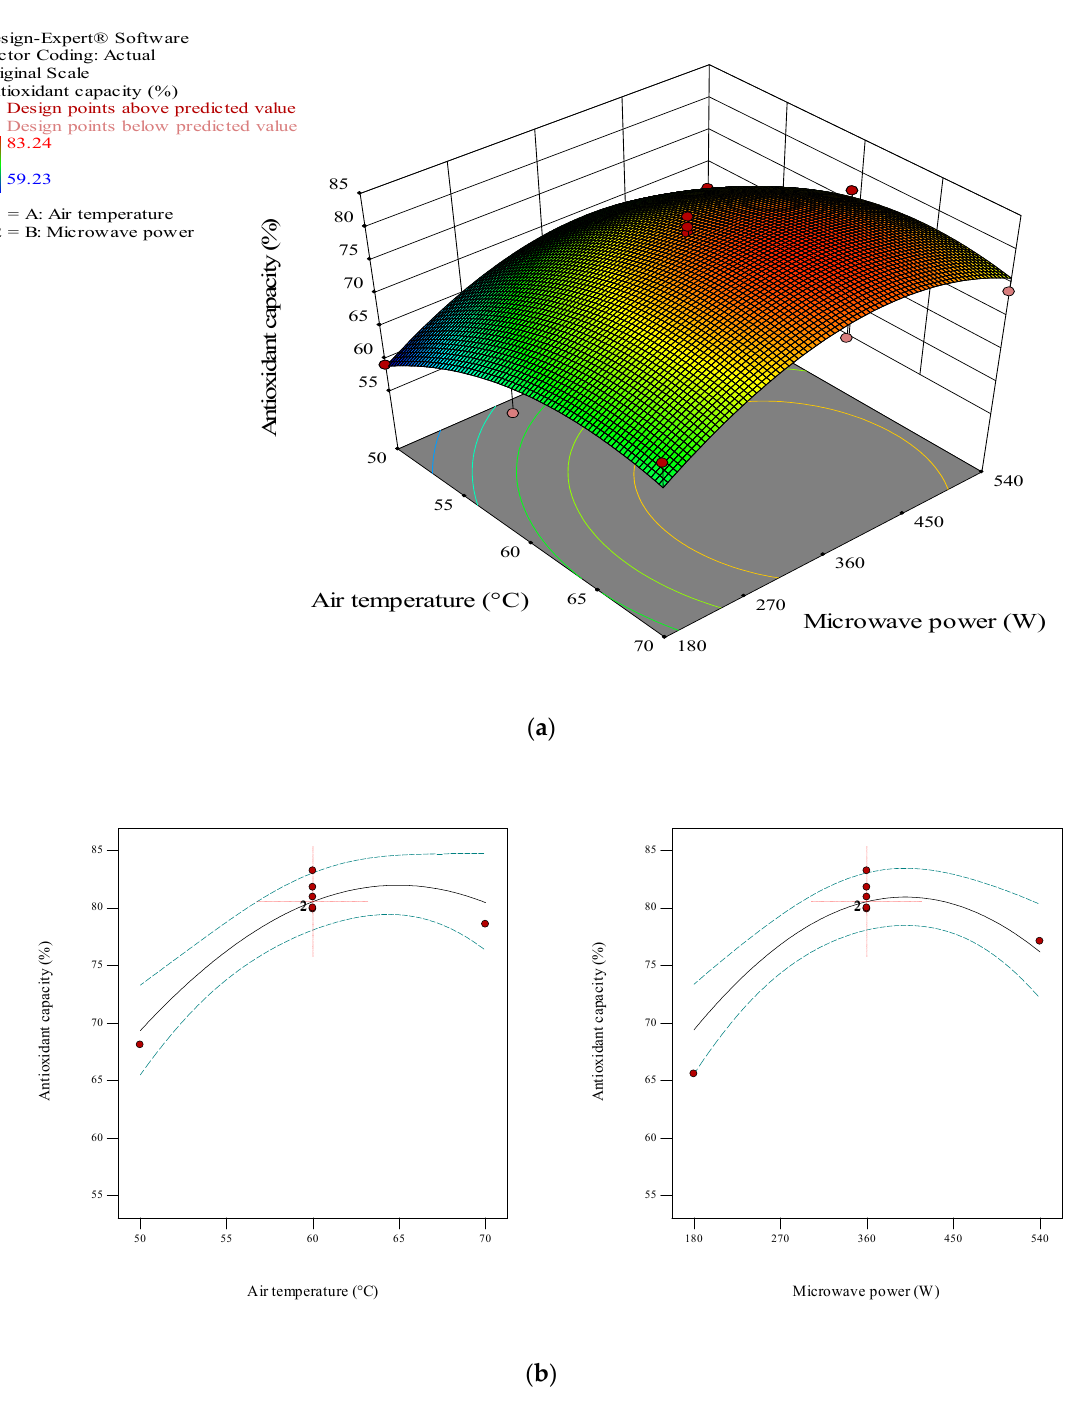
Figure 8. ( a ) The combined effect of air temperature and microwave power on AC. ( b ) The effect of air temperature and microwave power alone on AC.